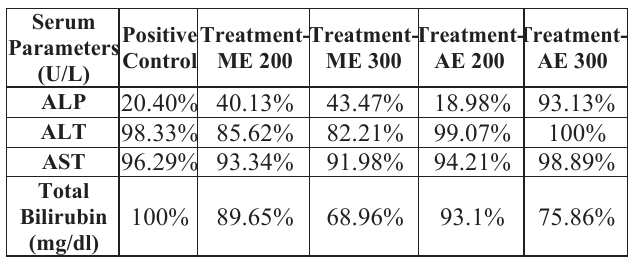
Table-2: Percentage protection after T. dioica extracts